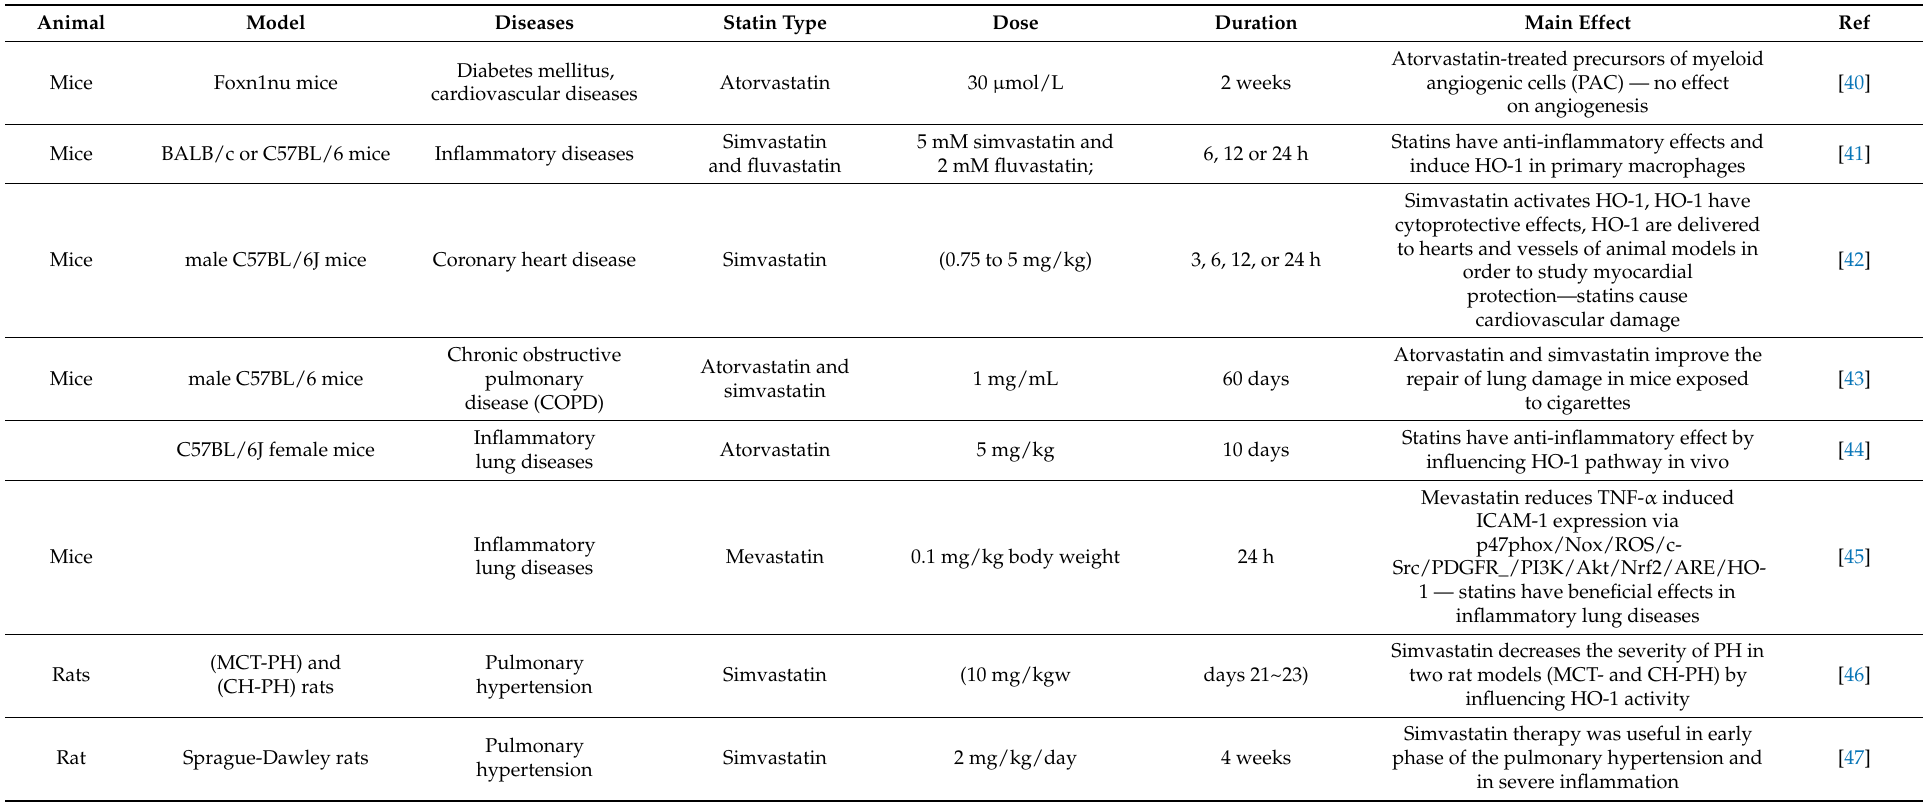
Table 1. Summary of in vivo studies investigating statin effect in various